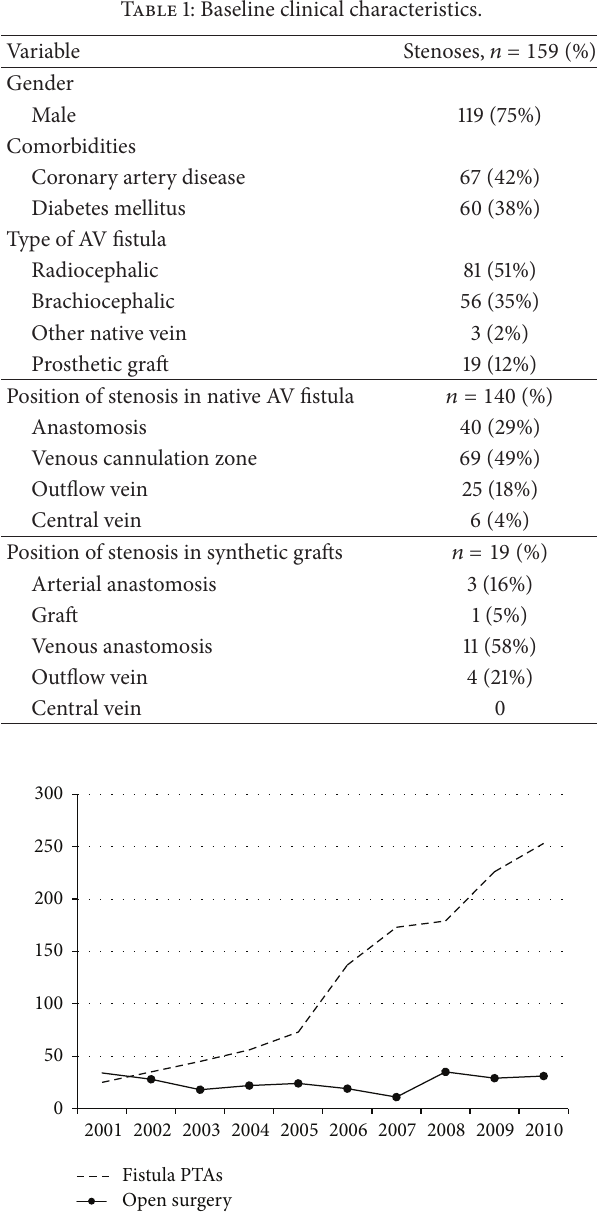
Figure 1: Number of PTAs and surgical operations in hemodialysis fistulas per year at our institution.